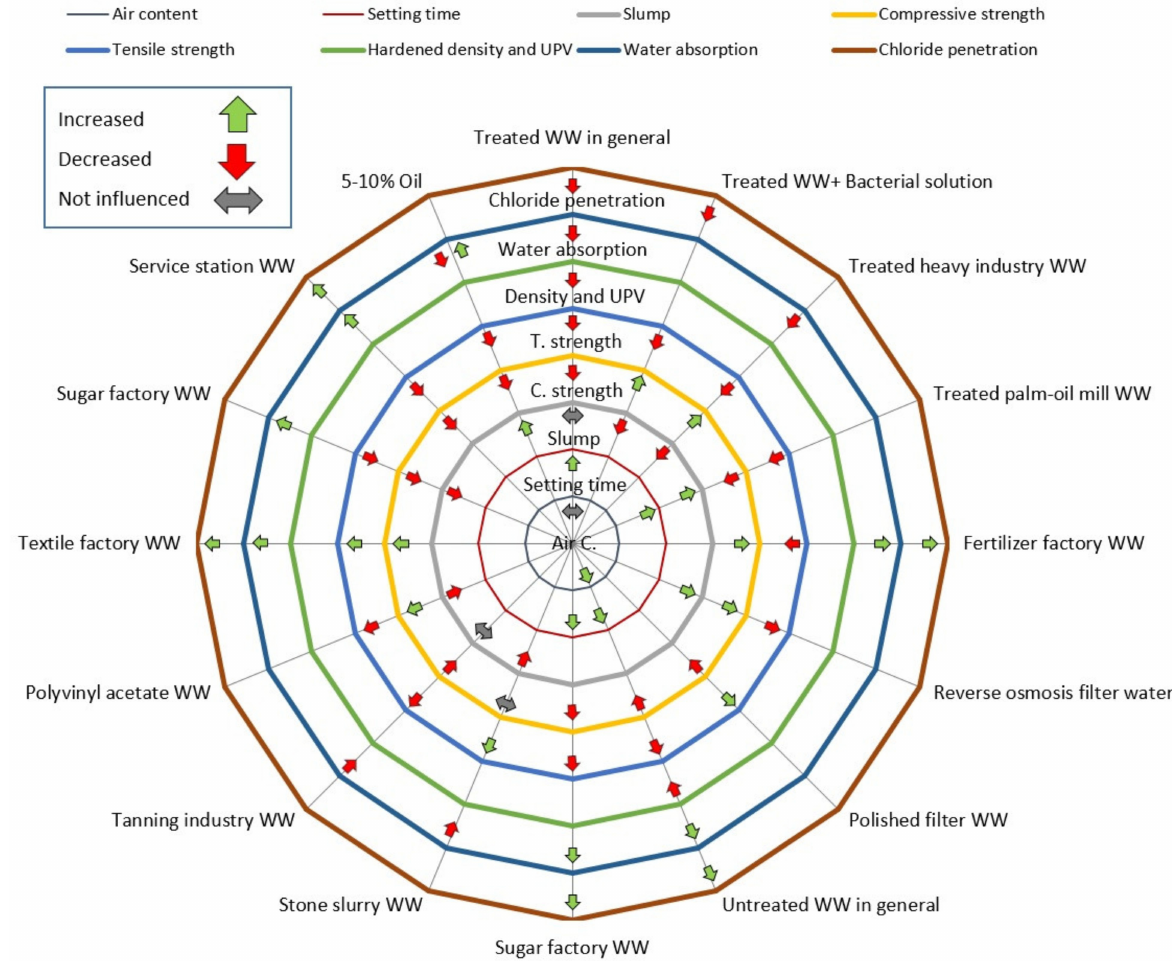
Figure 21. Effect of different types of treated and untreated WW on the performance of concrete based on the average data collected from the